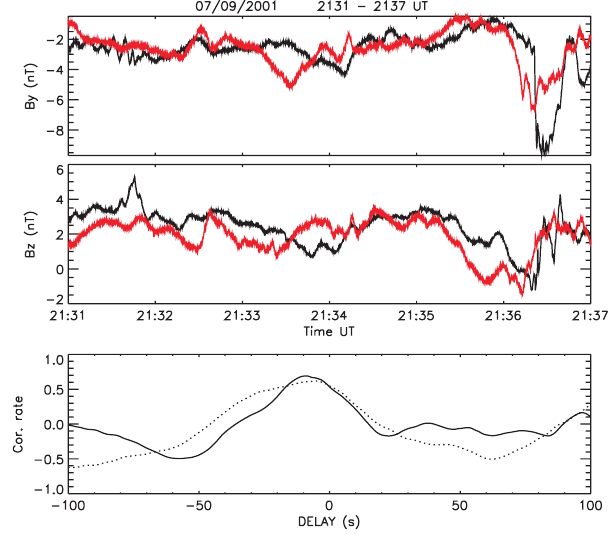
Fig. 12. B y and B z on S/C 1 and 2 at high-time resolution on 7 September between 21:31 and 21:37 UT. The full line is for the correlation function between B y (1) and B y (2), the dotted line gives the correlation function between B z (1) and B z (2). Time resolution of the correlation is 0.4s.